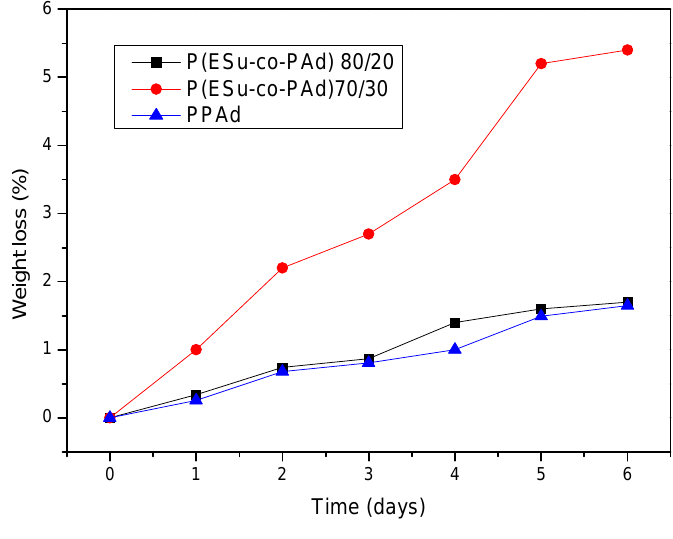
Figure 5. The percentage of mass loss vs time after enzymatic hydrolysis for P(ESu-co- PAd) copolymers.